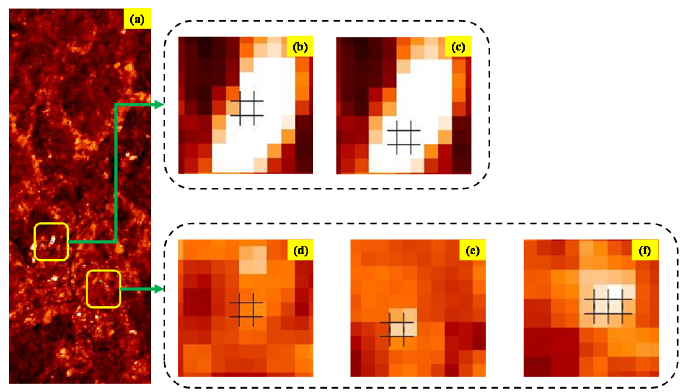
Figure 18. Target detection score image from ( a) space-borne imagery using space-borne target reference spectrum and the enlarged detection score footprint for ( b ) N3Y, ( c ) N4B, ( d ) N1G, ( e ) N2R, and ( f ) C1W target.